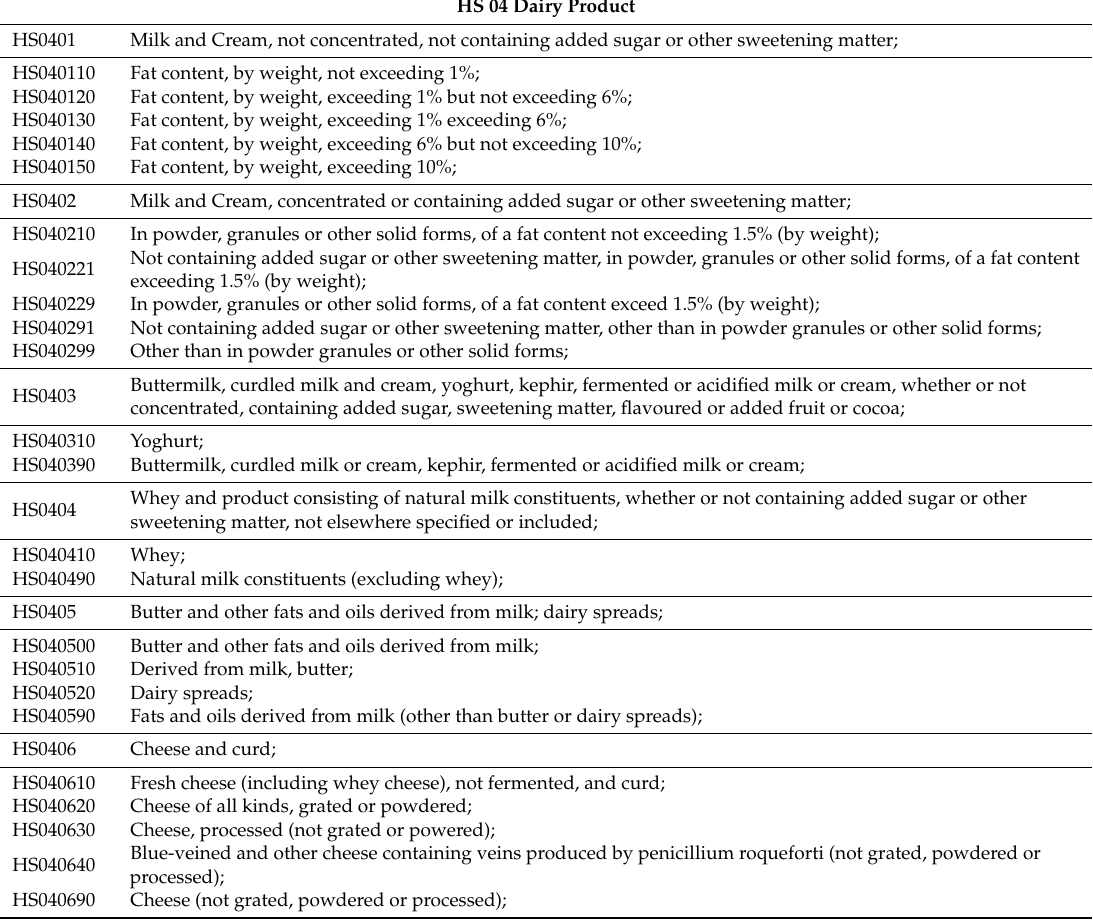
Table 7. Harmonized System Sectors